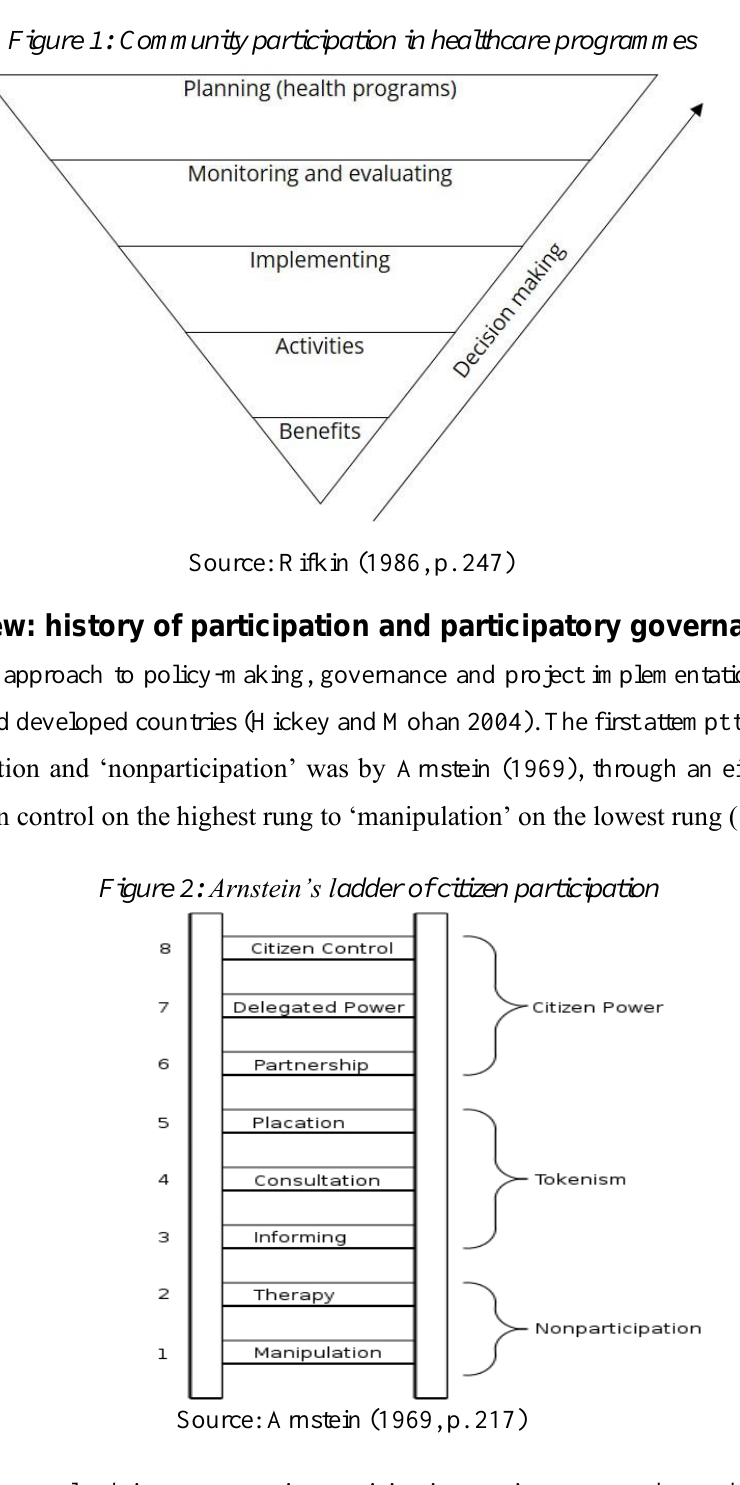
Figure 1: Community participation in healthcare programmes